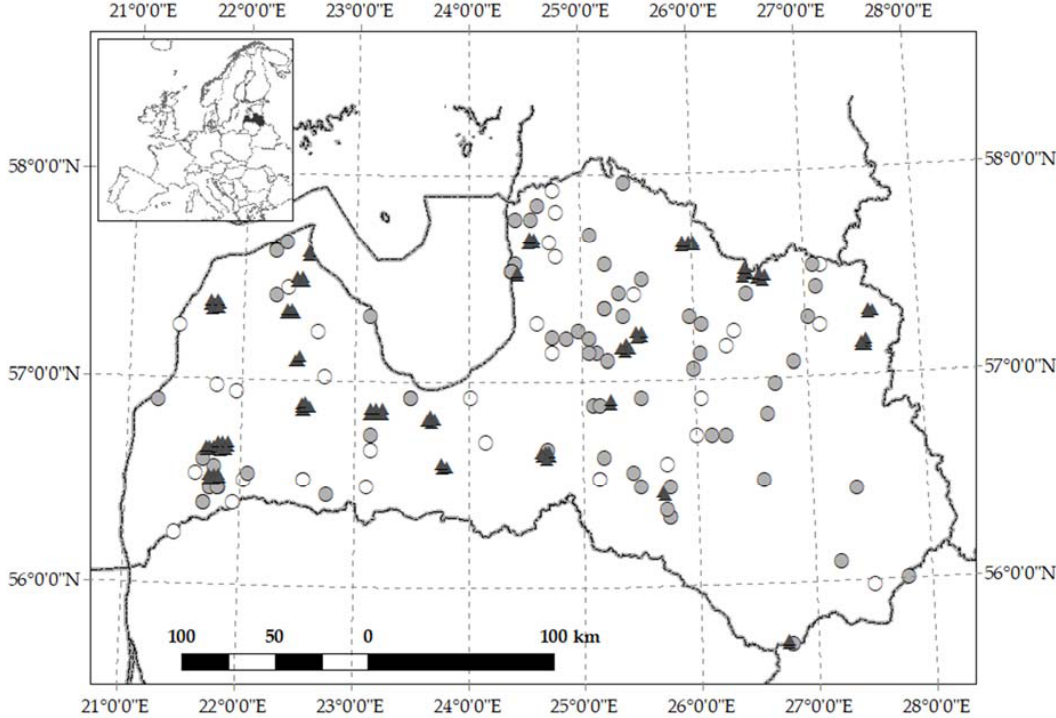
Figure 1. Distribution of sample plots in mature and old-growth stands. Triangles denote old-growth stands and circles denote mature stands, with dark-coloured circles indicating unmanaged mature stands.